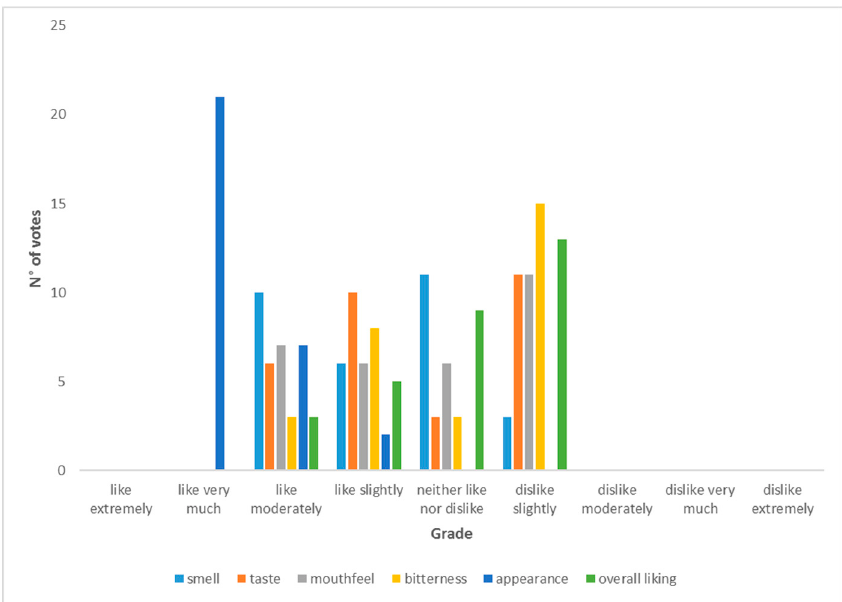
Figure 14. Hedonic nine-point scale grading for beer 5 (0% lactose and 100% coffee).